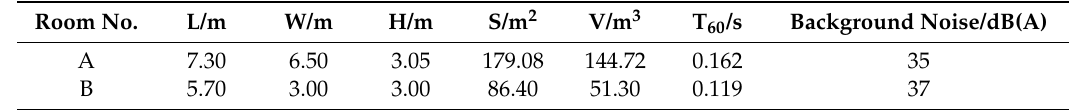
Figure 1. Binaural signal collection scene in real rooms. ( a ) Room A ( b ) Room B.